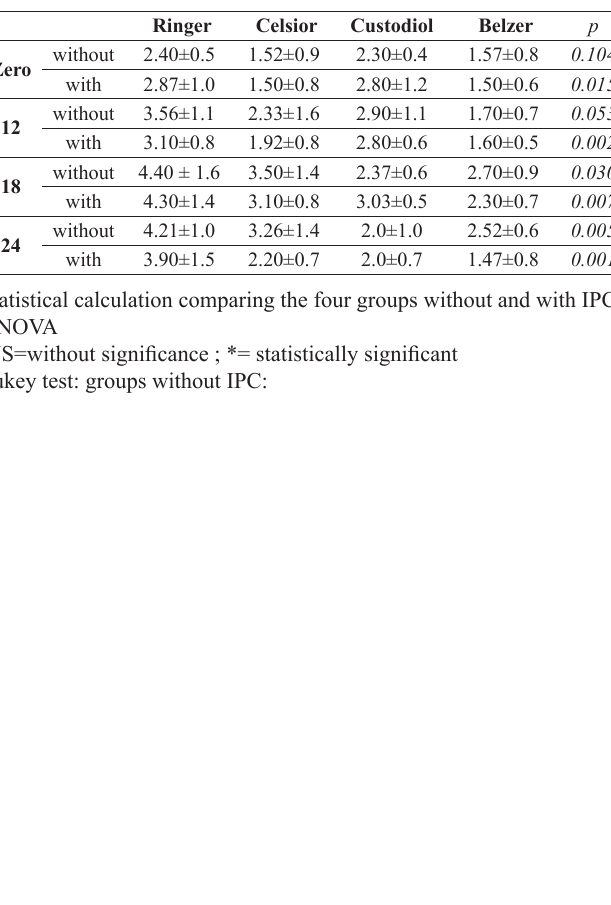
TABLE 1 - Mean and standard deviation of MDA value, in nmol/mg tissue, groups Ringer, Celsior, Custodiol and Belzer, without and with ischemic preconditioning, at zero, 12, 18 and 24 hours of preservation.